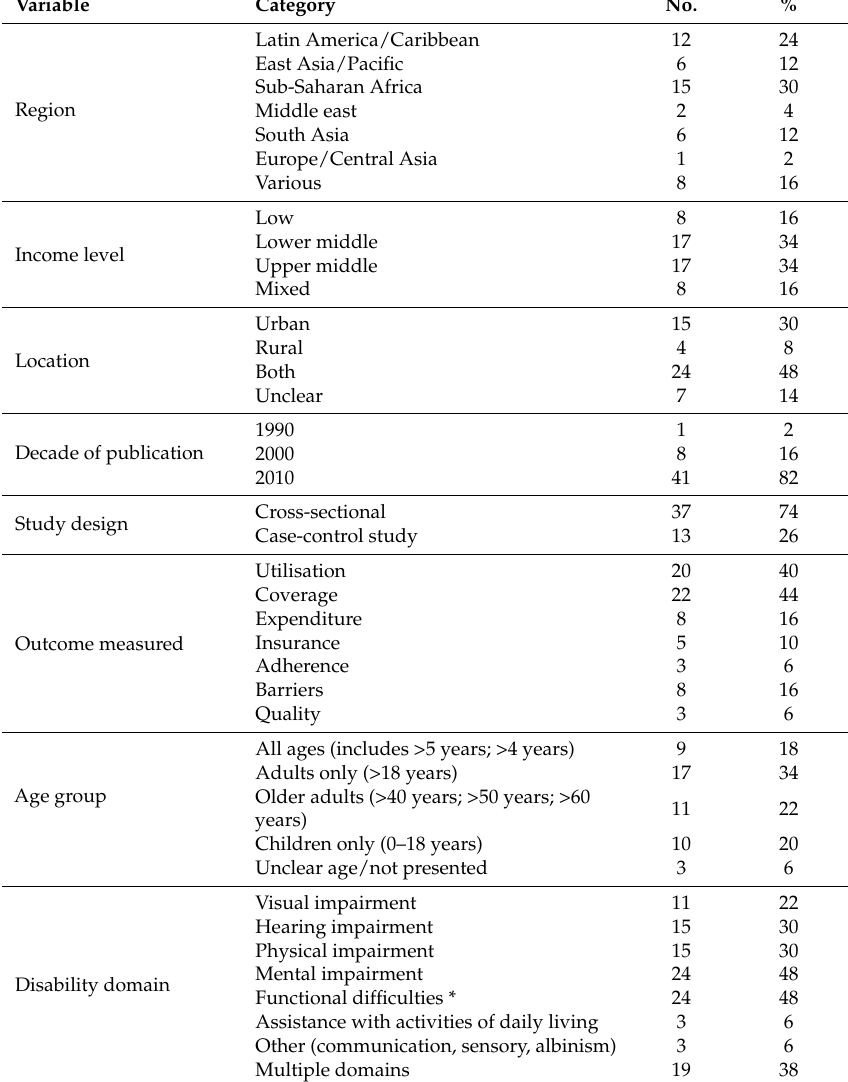
Table 2. Characteristics of included